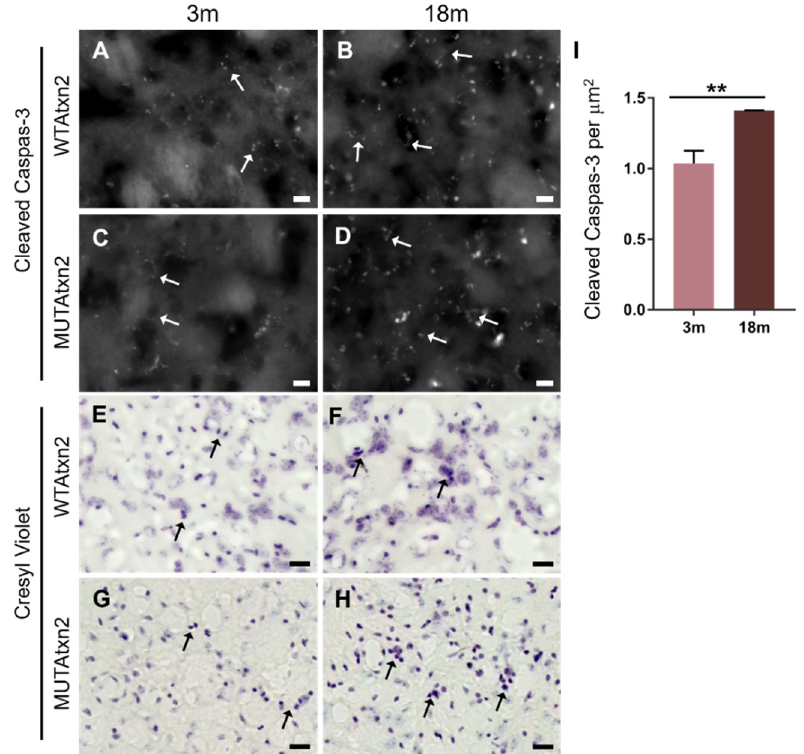
Figure 3. Cell death markers are increased in older animals injected with MUTAtxn2. ( A – D ) Representative images of striatal sections stained for cleaved caspase-3 (white arrows). Scale bar: 10 µ m. ( I ) Quantitative analysis of cleaved caspase-3 marker in 3 m and 18 m animals injected with MUTAtxn2. ( E – H ) Representative cresyl violet staining of striatal sections in the 3 m and 18 m animal groups (black arrows). Scale bar: 20 µ m. Values are expressed ± SEM (standard error of the mean) (unpaired t -test with Welch’s correction, ** p <